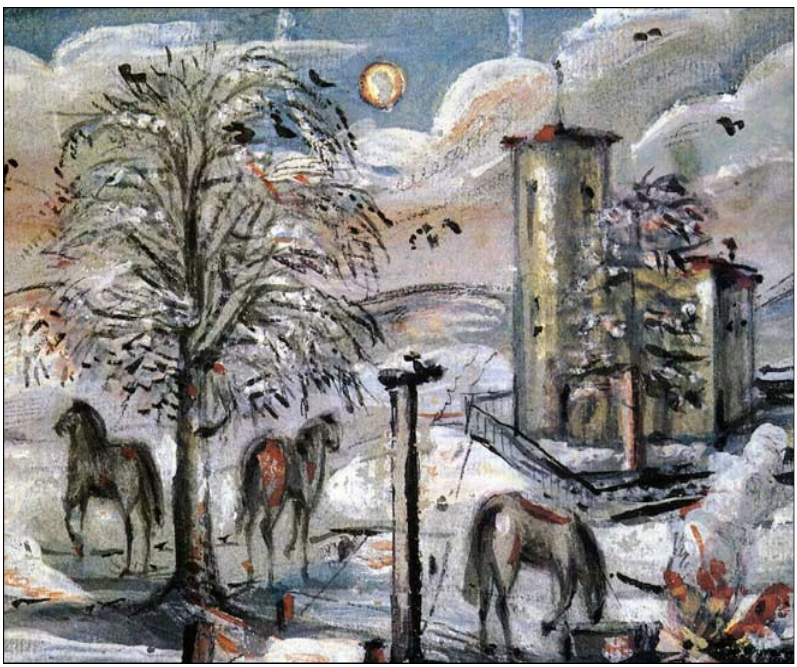
Figure 36. Konstantin Batiushkov. Landscape with Horses , 1830. State Literary Museum, Moscow.